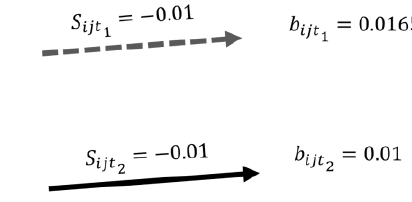
Figure 2. Example of the calculation of 𝑏 𝑖𝑗𝑡 with Criterion 1.